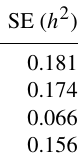
Table 3. Estimated genetic variances (diagonal) and covariances (below diagonal).